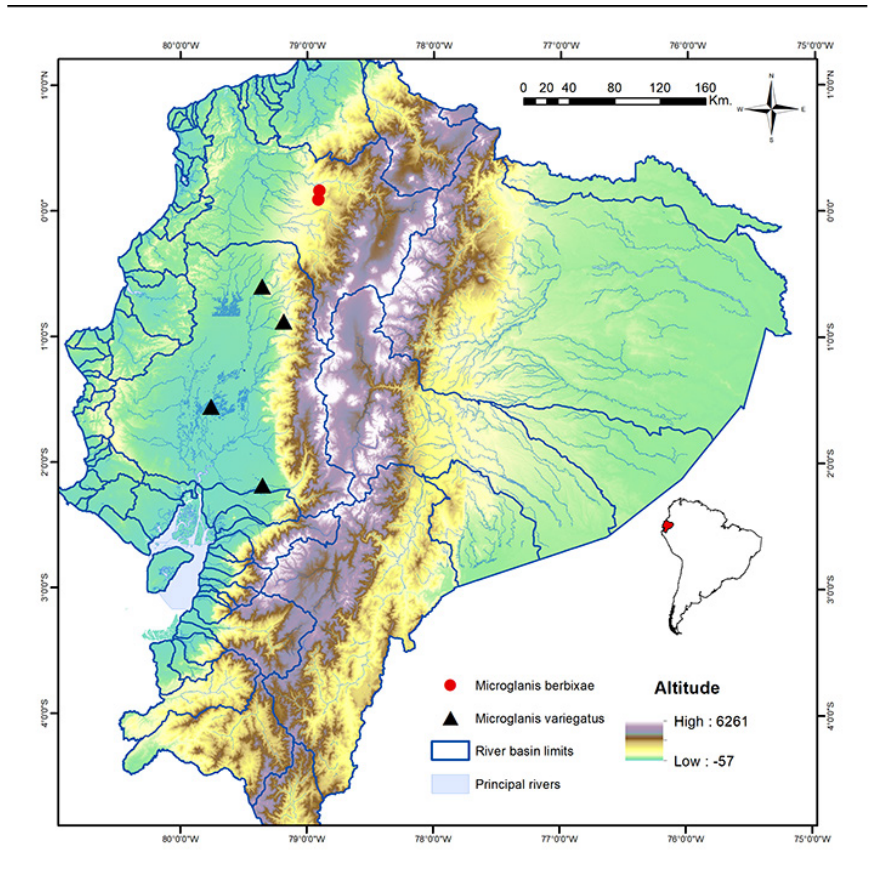
FIGURE 8 | Map of Ecuador showing capture localities of Microglanis berbixae (red dots) and Microglanis variegatus (black triangles).